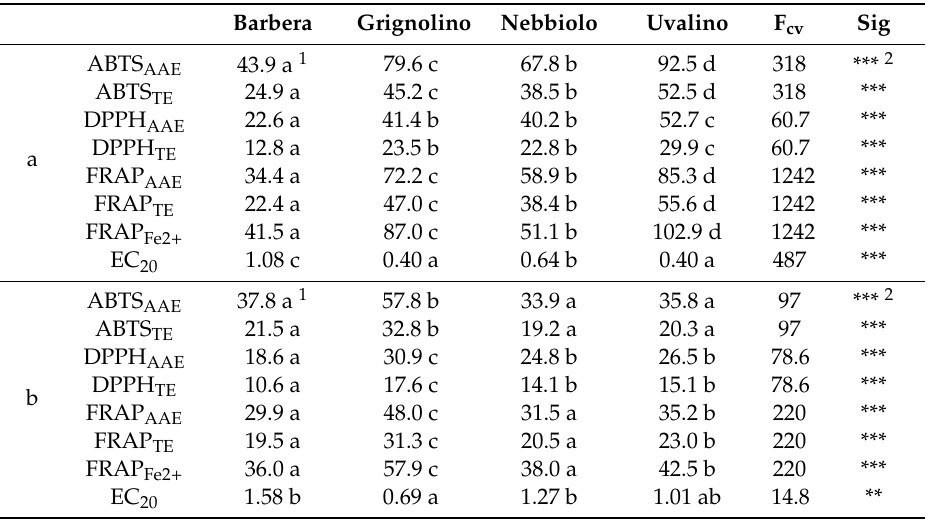
Table 4. Average results of the antioxidant tests performed (a) after 2 days of maceration and (b) after racking o ff . ANOVA and Tukey’s test results. AAE: mg of ascorbic acid equivalent per 1 g of seed flour (1 g DW); TE: mmols of Trolox equivalent per 100 g DW; Fe 2 + : mmols Fe 2 + / 100 g DW; EC 20 (E ffi cient Concentration): Quantity in mg of seed flour (DW) necessary to determine a 20% inhibition to 1 mg of 2,2 diphenyl-1-picrylhydrazyl